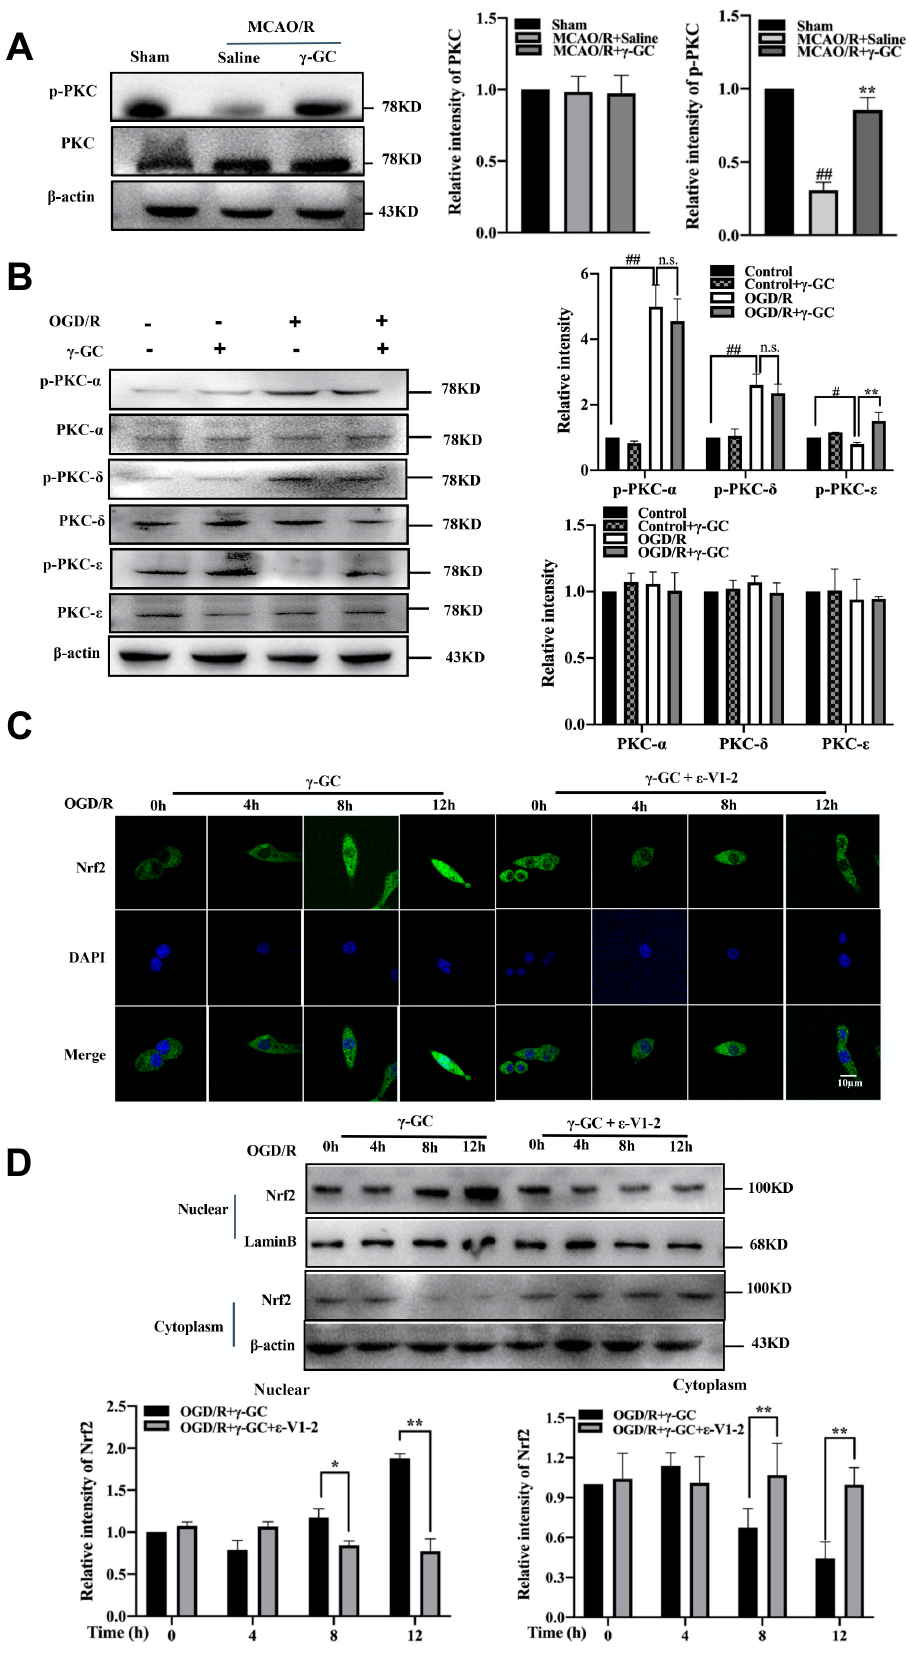
Figure 7. γ -GC activates Nrf2 through promoting phosphorylation of PKC- ε . ( A ) Rats were treated with γ -GC (688 mg/kg body weight) after being subjected to 1.5 h of MCAO. Twenty-four